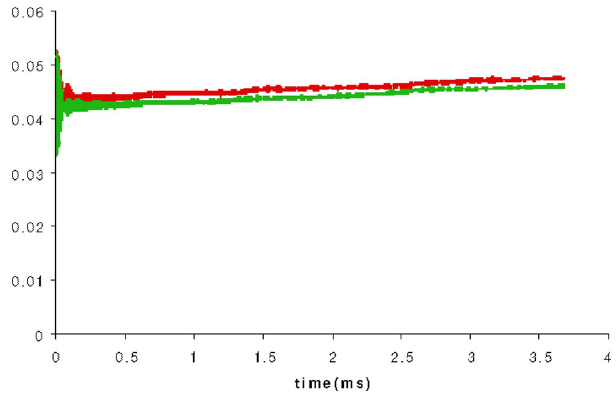
FIG. 46. (Color) QUICKPIC simulation result by Ghalam and Katsouleas of horizontal and vertical emittance growth for the code benchmarking with the parameters of Table I; the horizon- tal scale extends over 4 ms, the vertical from 0 to 0 : 06 (cid:7) m ; a continuous electron-beam interaction was modeled.